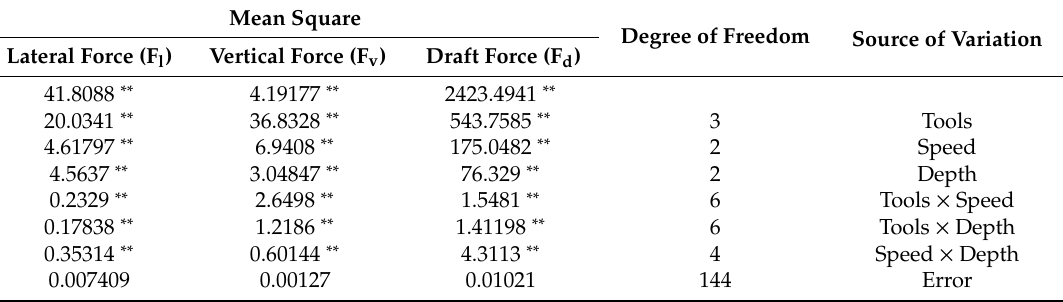
Table 2. Analysis of variance related to the measurement of forces acting on tillage